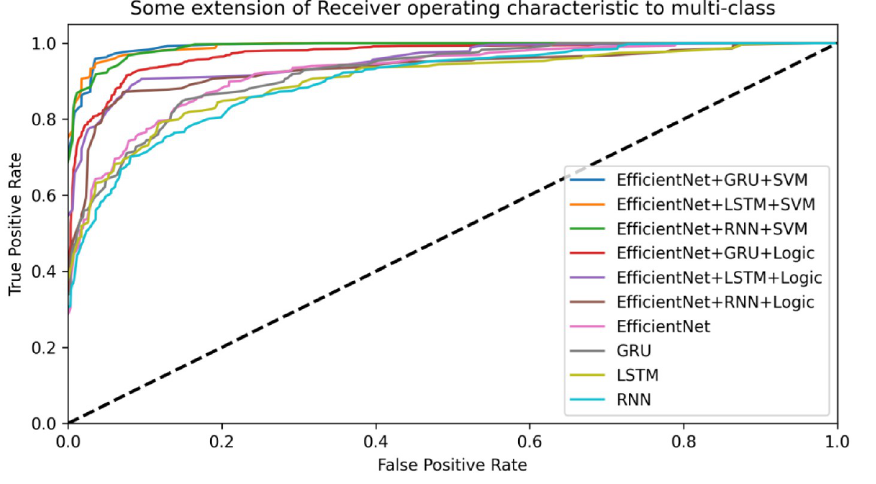
Fig 11. Comparison of ROC curves of each